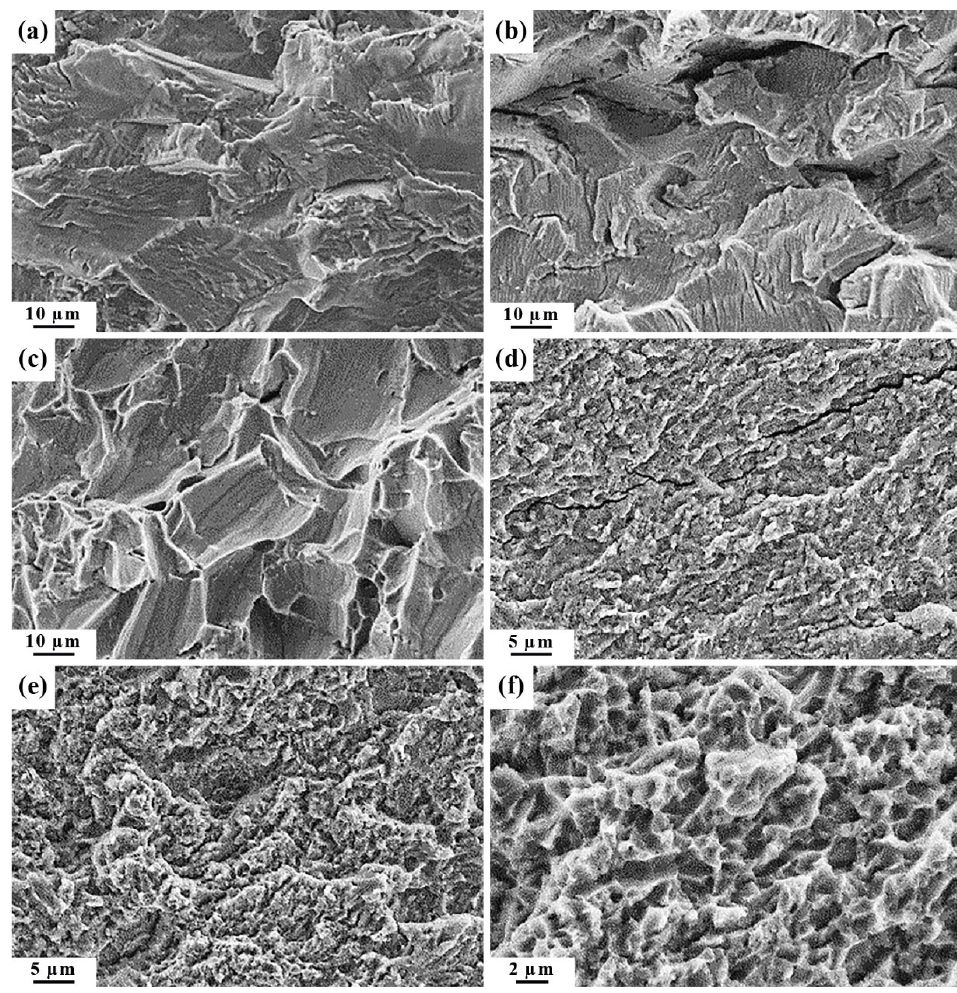
Figure 5. Fatigue fracture surface microrelief of the specimens from CG ( a – c ) and UFG ( d – f ) Ti: ( a , d ) in the vicinity of the crack initiation nucleus; ( b , e ) in the vicinity of the final failure zone; ( c , f ) in the final failure zone; ( a – c ) ×1000, ( d , e ) ×2000; ( f ) ×4000.